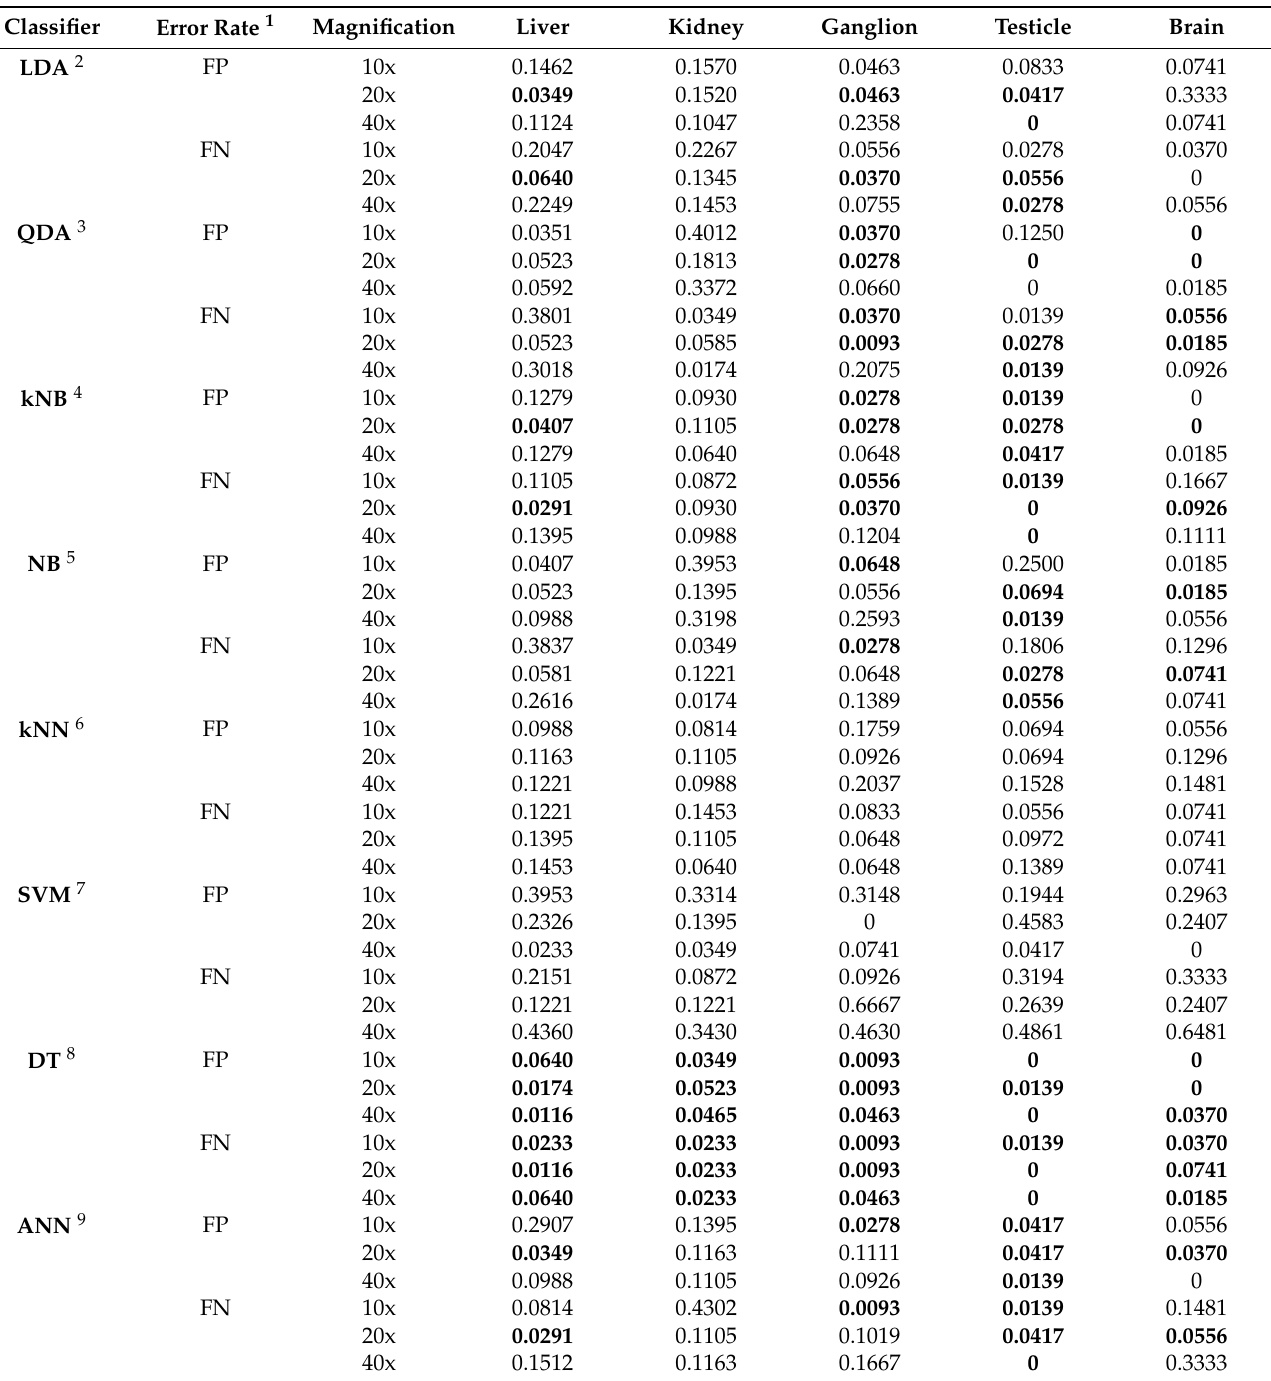
Table 3. Results of the re-substitution error, expressed separately for the false positive and false negative rates, for each tissue type and magnification. Combinations with total re-substitution error (FP + FN) < 0.1 are marked in